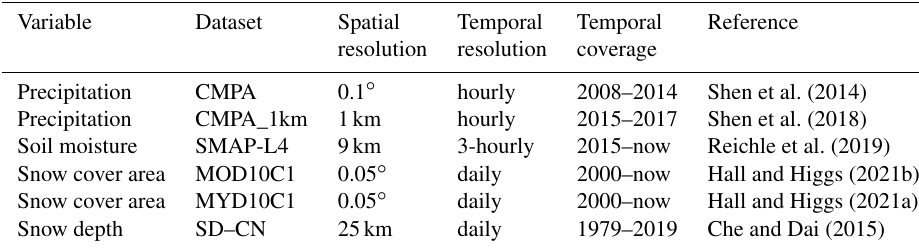
Table 2. Sources of validation